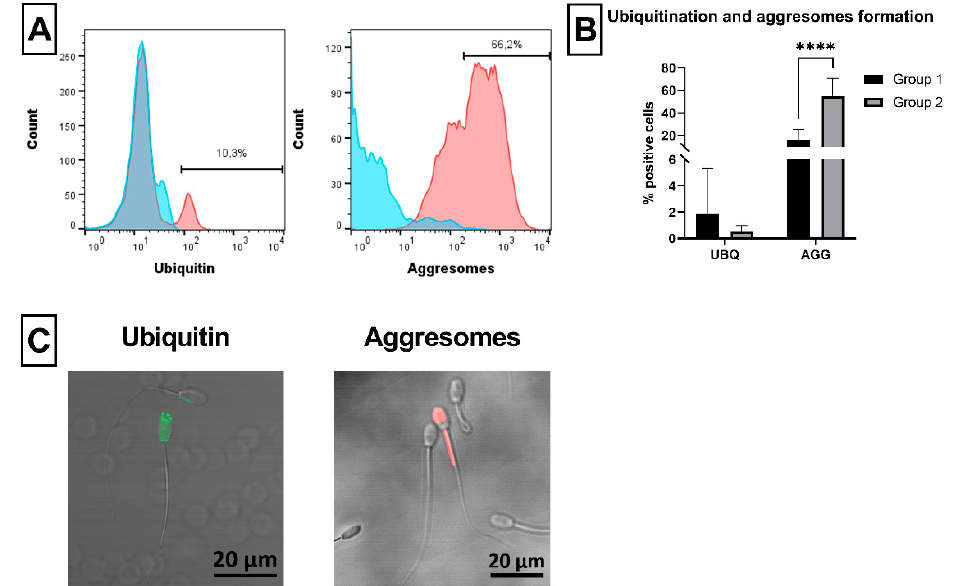
Figure 7. Evaluation of defective spermatozoa with ubiquitinated proteins and aggresomes. Illus- trative flow-cytometric histograms showing evaluation strategy of analyzed fluorescent markers. Spermatozoa gated using FSC/SSC dot plot were showed using histogram in green FL1 channel (UBQ) or red FL3 channel (Aggresomes), where a control unstained population (blue) was com- pared to positively stained population (red) according to fluorescent signals ( A ). Graph showing comparison of defective spermatozoa detected using anti-ubiquitin antibody (UBQ) or